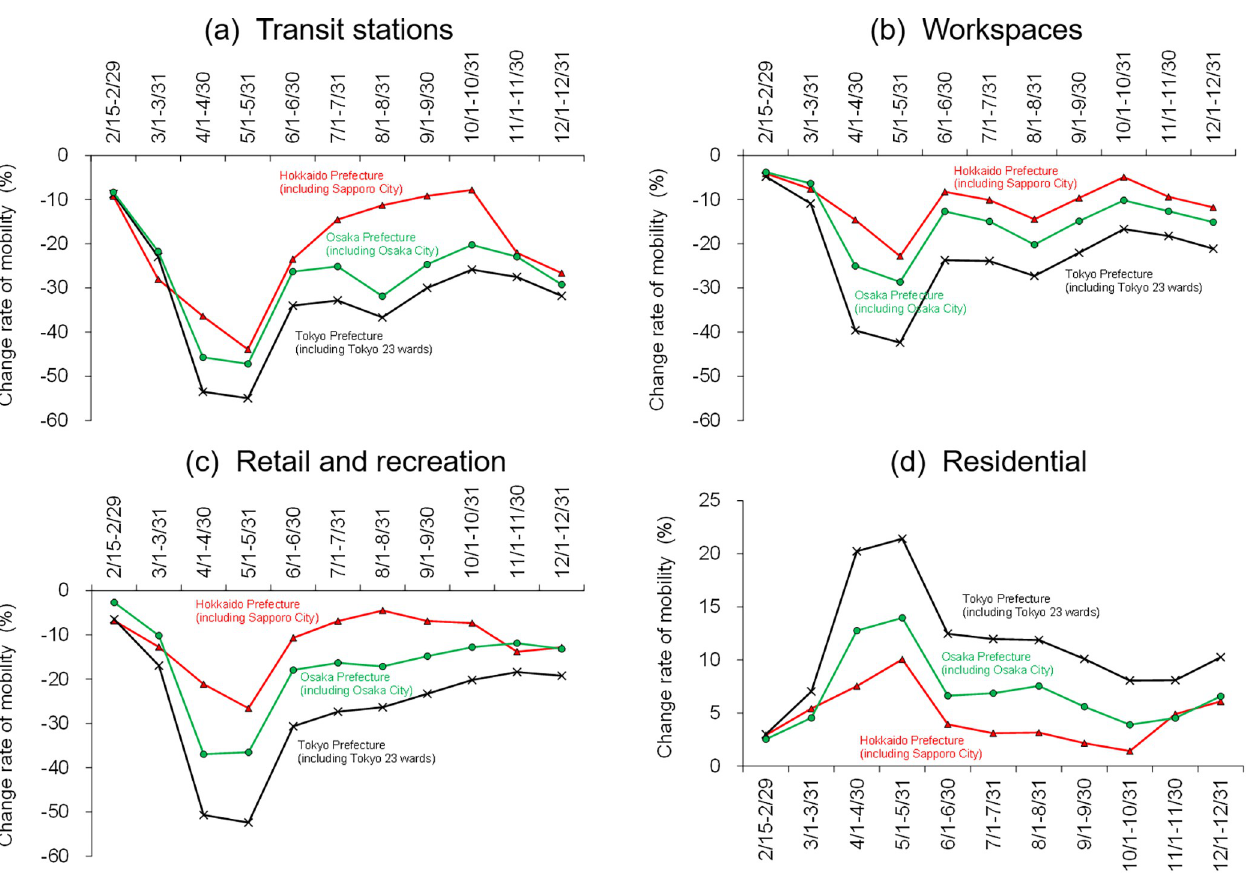
Fig 8. Temporal variations of the change rate of human mobility in Hokkaido prefecture (including Sapporo City), Tokyo prefecture (including Tokyo 23 wards), and Osaka prefecture (including Osaka City) during the period from 15 February to 31 December 2020. Results at (a) transit stations, (b) workspaces, (c) retail and recreation, and (d) residential, from the Google COVID-19 community mobility